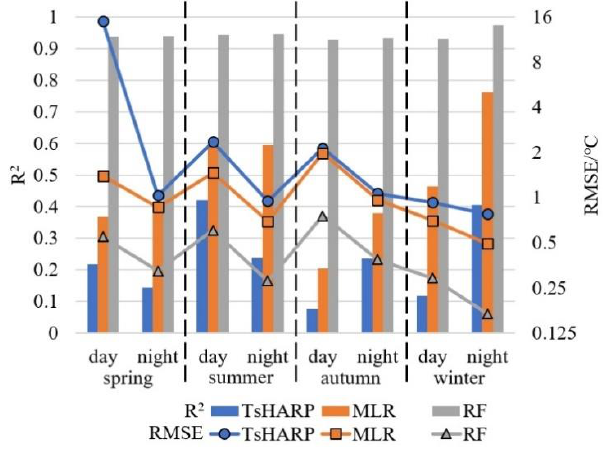
Figure 12. Prediction precision for TsHARP, MLR, and RF models of low-resolution LST for the entire research region. (Histogram represents R 2 ; line chart represents RMSE).